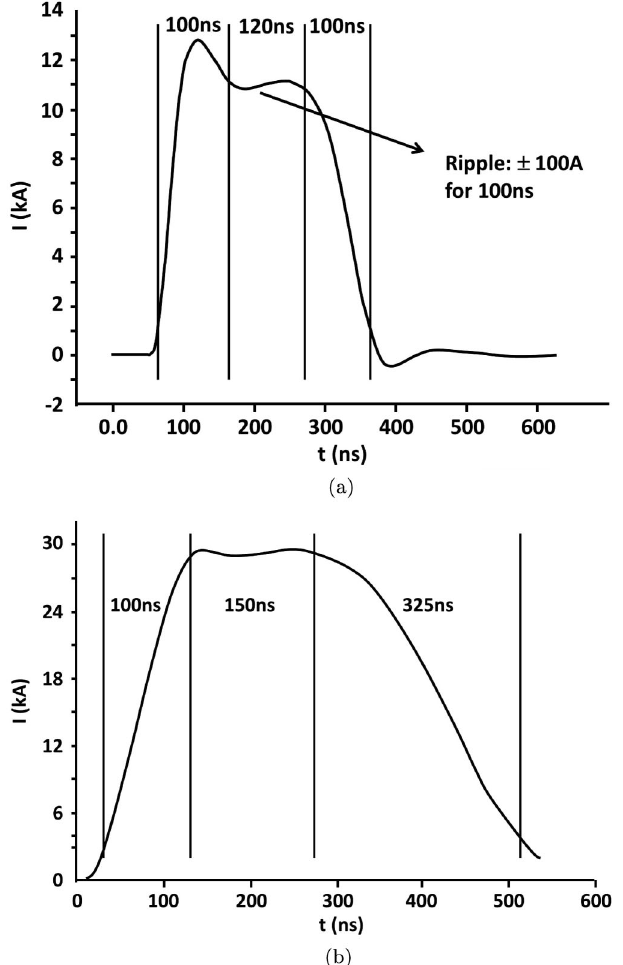
FIG. 38. Pulse shapes of the (a) proton and (b) carbon kicker.